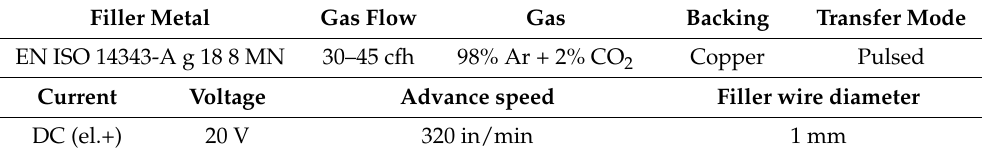
Table 5. Welding operation mode.